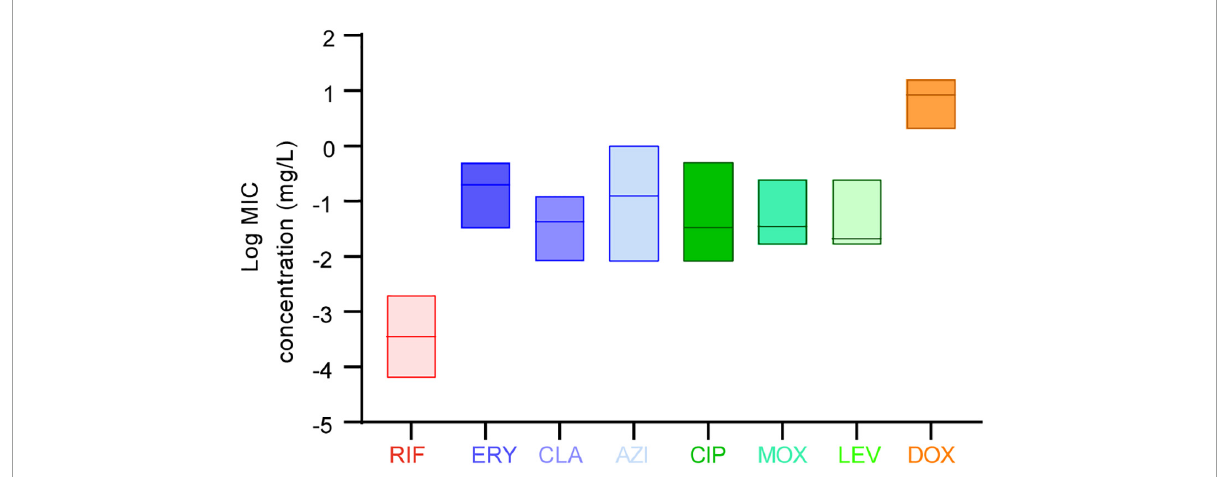
FIGURE1 Average minimum inhibitory concentrations (MICs) among the eight antibiotics against L. pneumophila. Data are shown as floating bars with the max, min, and mean